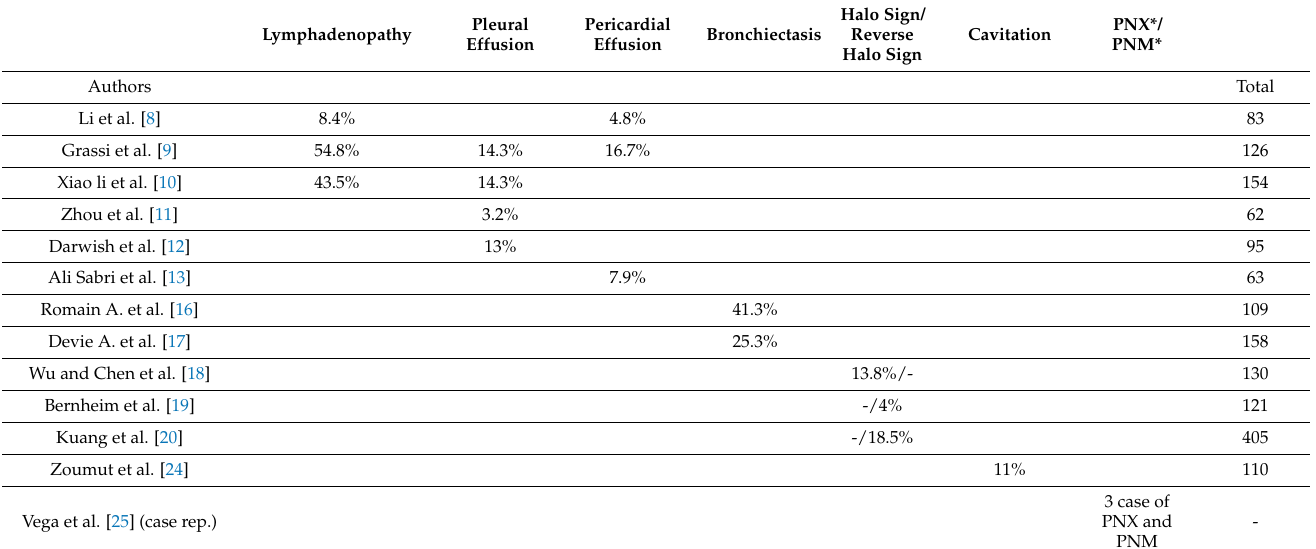
Table 1. Adults “atypical” and “complicated” pulmonary COVID-19.